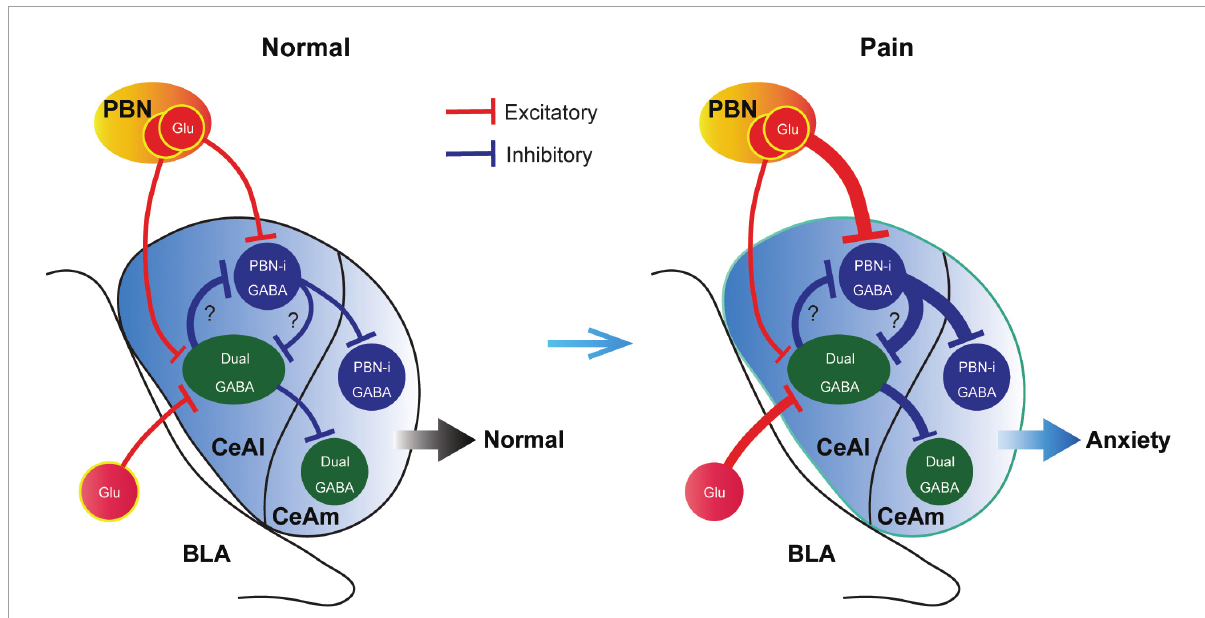
FIGURE8 A schematic illustrating a working model of opposing cell types and synaptic circuits in normal and pain-anxiety conditions. Glu, glutamate; PBN-i,